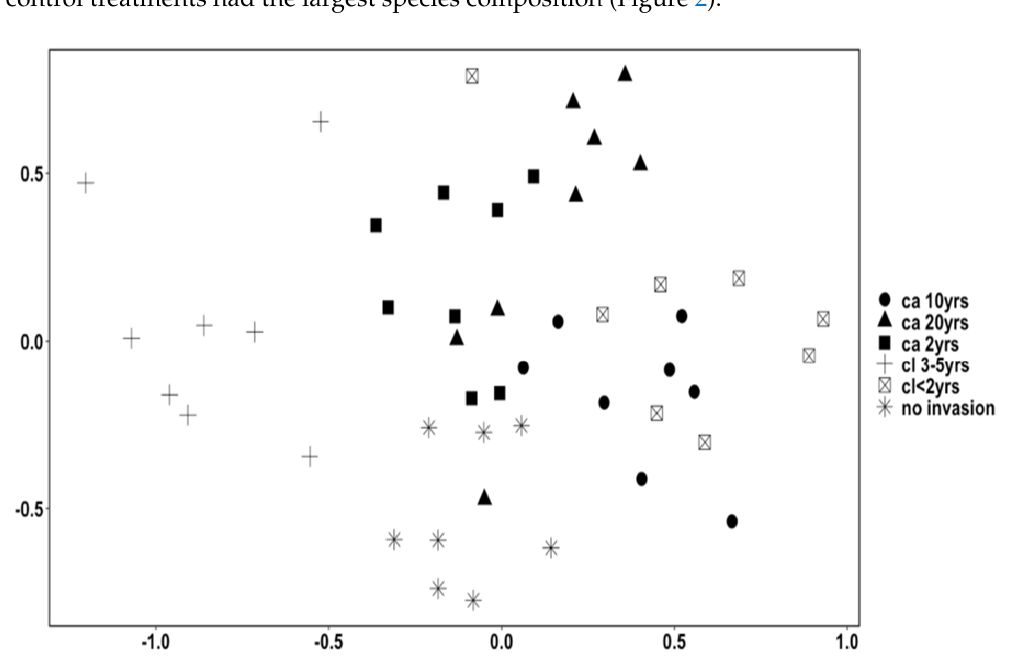
Figure 2. MDS plot (derived from Bray_Curtis dissimilarity in square root transformed data, Stress value = 0.148) showing large mammal assemblages of the six areas with differing L. camara invasion durations ( ca ), differing L. camara clearing ( cl ) times, and a control area with no L. camara invasion in Groenkloof Nature Reserve, South Africa.